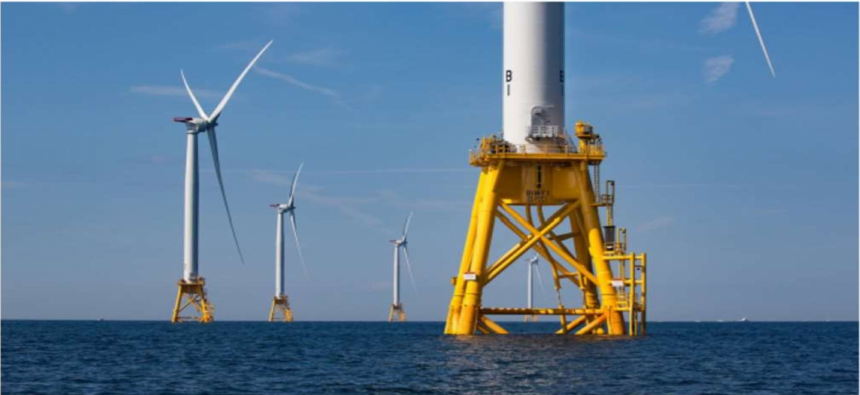
Figure 22. Structures for the Block Island wind farm